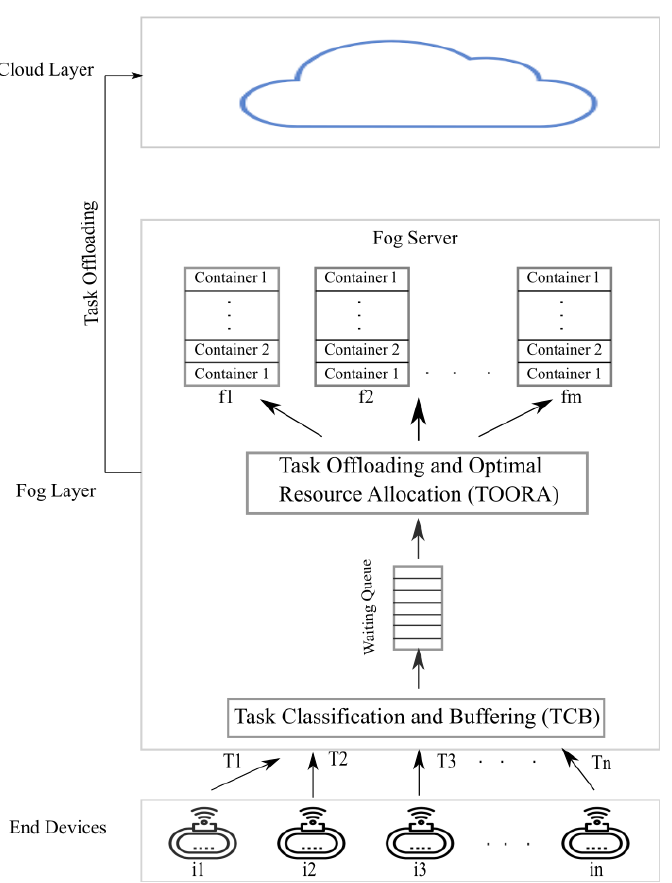
Figure 1. System